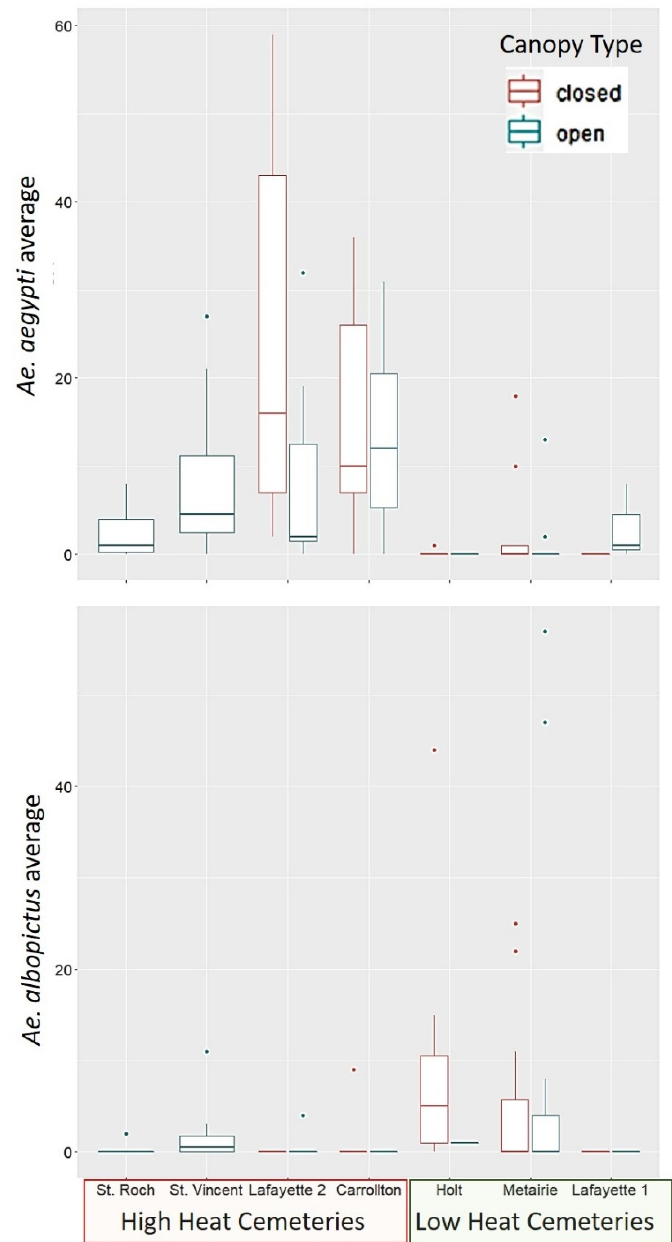
Figure 4. Relationship between mosquito abundance heat index (UHI) at the cemetery scale (high/low)), and canopy cover type at the container scale (closed/open). Other cemetery scale factors measured (vegetation index, median income) were not illustrated due to lack of significant relationship with the species collected with this study.